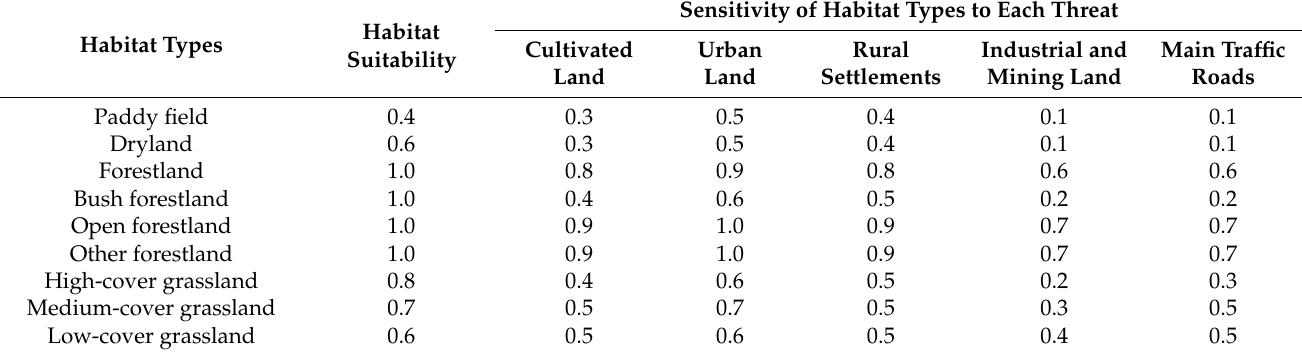
Table 2. Habitat suitability of each habitat type and their sensitivity to